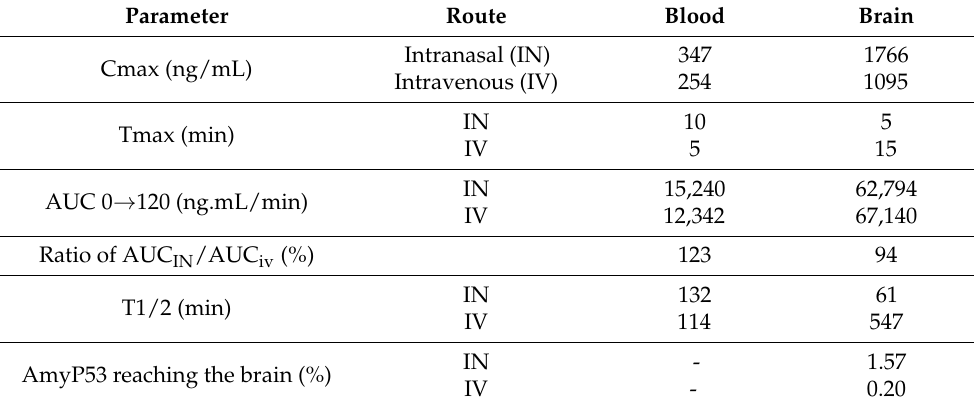
Figure 4. In vitro stability studies of AmyP53 in rat whole blood and human serum. AmyP53 was incubated at a concentration of 300 µM with rat whole blood ( A ) or human serum ( B ). At the indicated times, samples were extracted and underwent AmyP53 quantification by LC–MS. Data are expressed as mean ± SD (n = 3). Table 2. Pharmacokinetics parameters following the intravenous and nasal administration of AmyP53 in